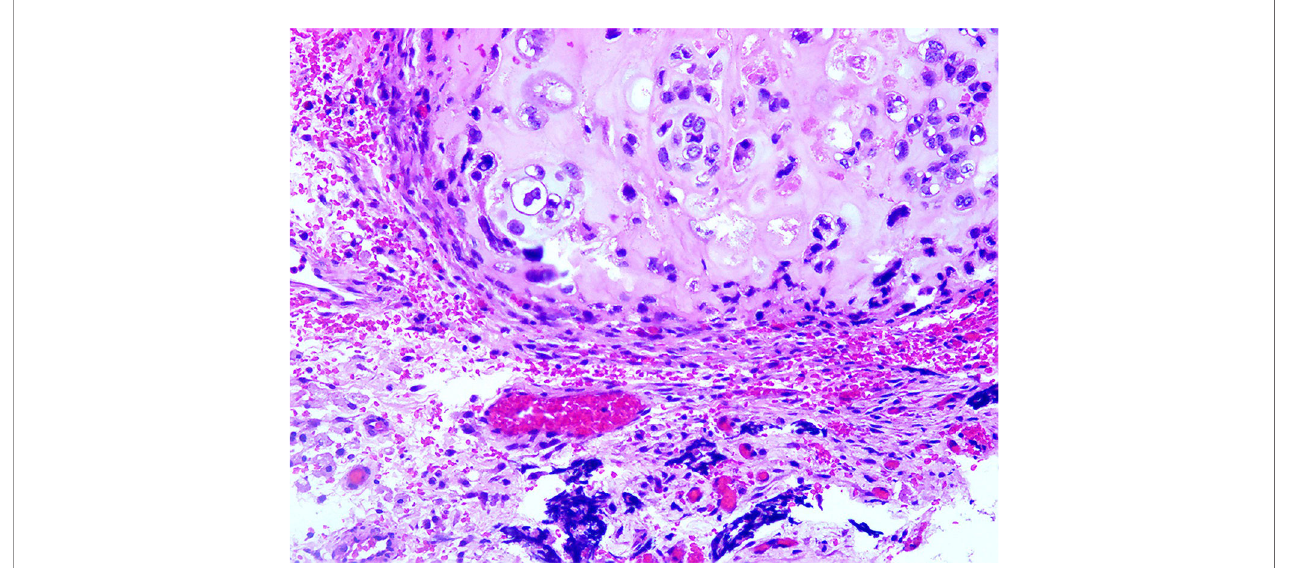
FIGURE 1 | Sarcoma component